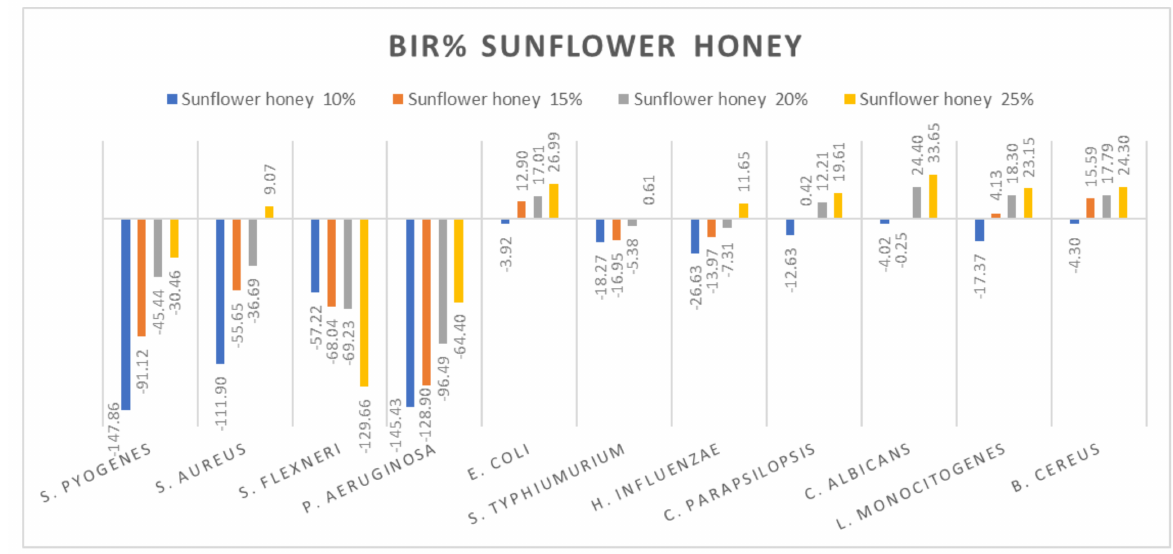
Figure 11. Sunflower honey antimicrobial activity (expressed as BIR%/MIR%) on ATCC